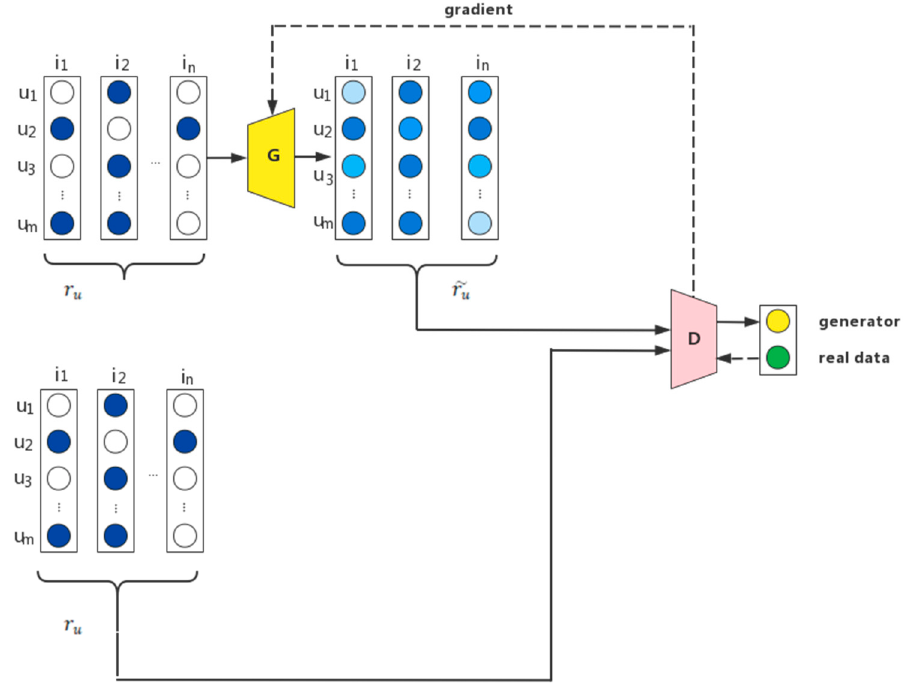
Figure 3. Framework diagram of CFGAN model.